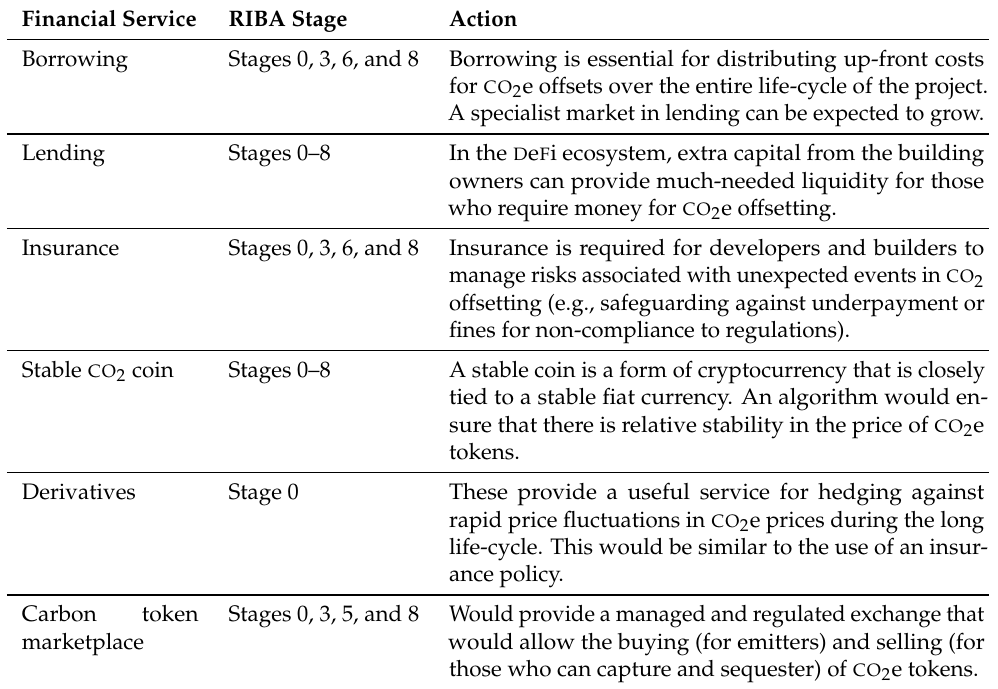
Table 1. A list of financial services useful for developers and constructors to manage their carbon budgets and minimize full life cycle carbon